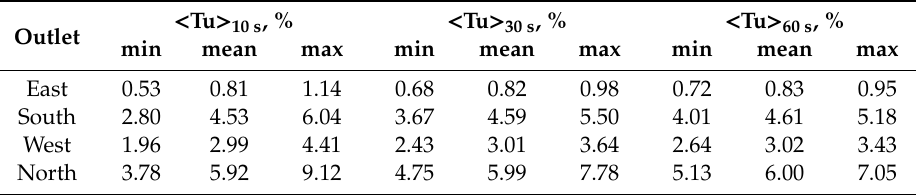
Table 5. Turbulent intensity at four points located near four supply sections of fan coil #4.